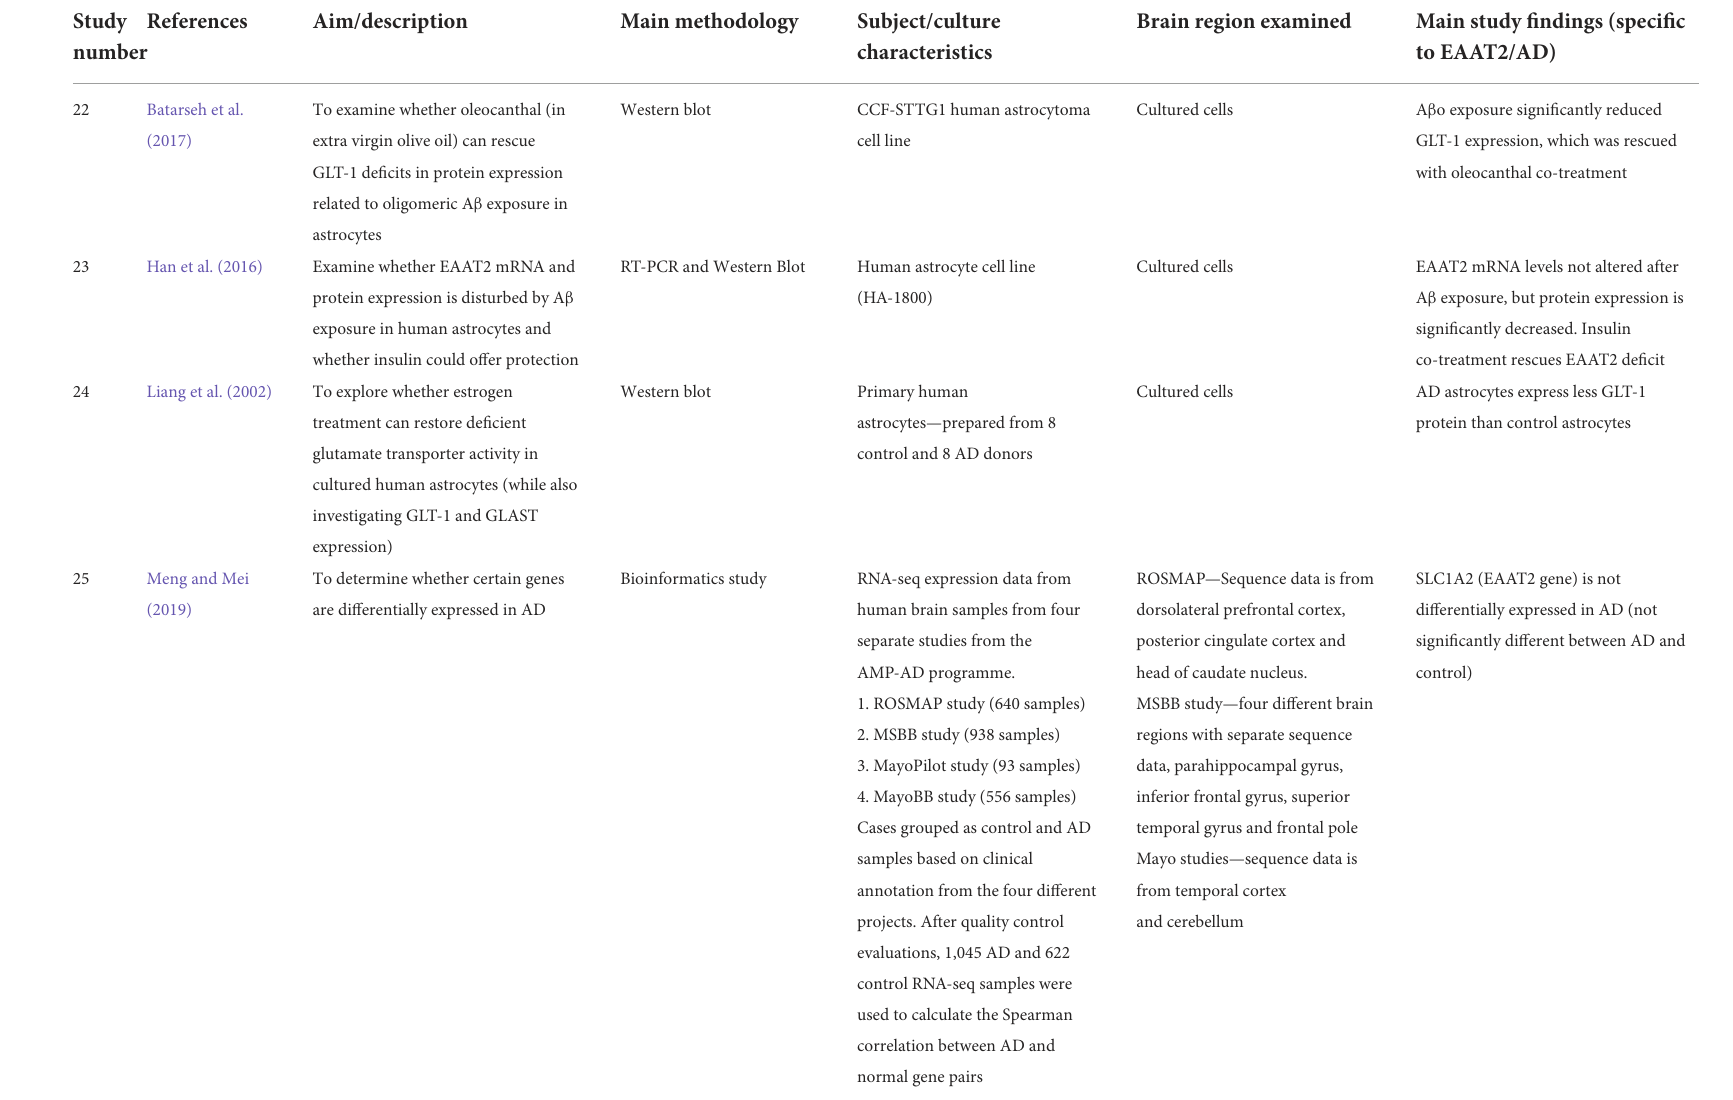
TABLE 2 Summary of cell culture, gene expression and other human EAAT2 studies included in this systematic